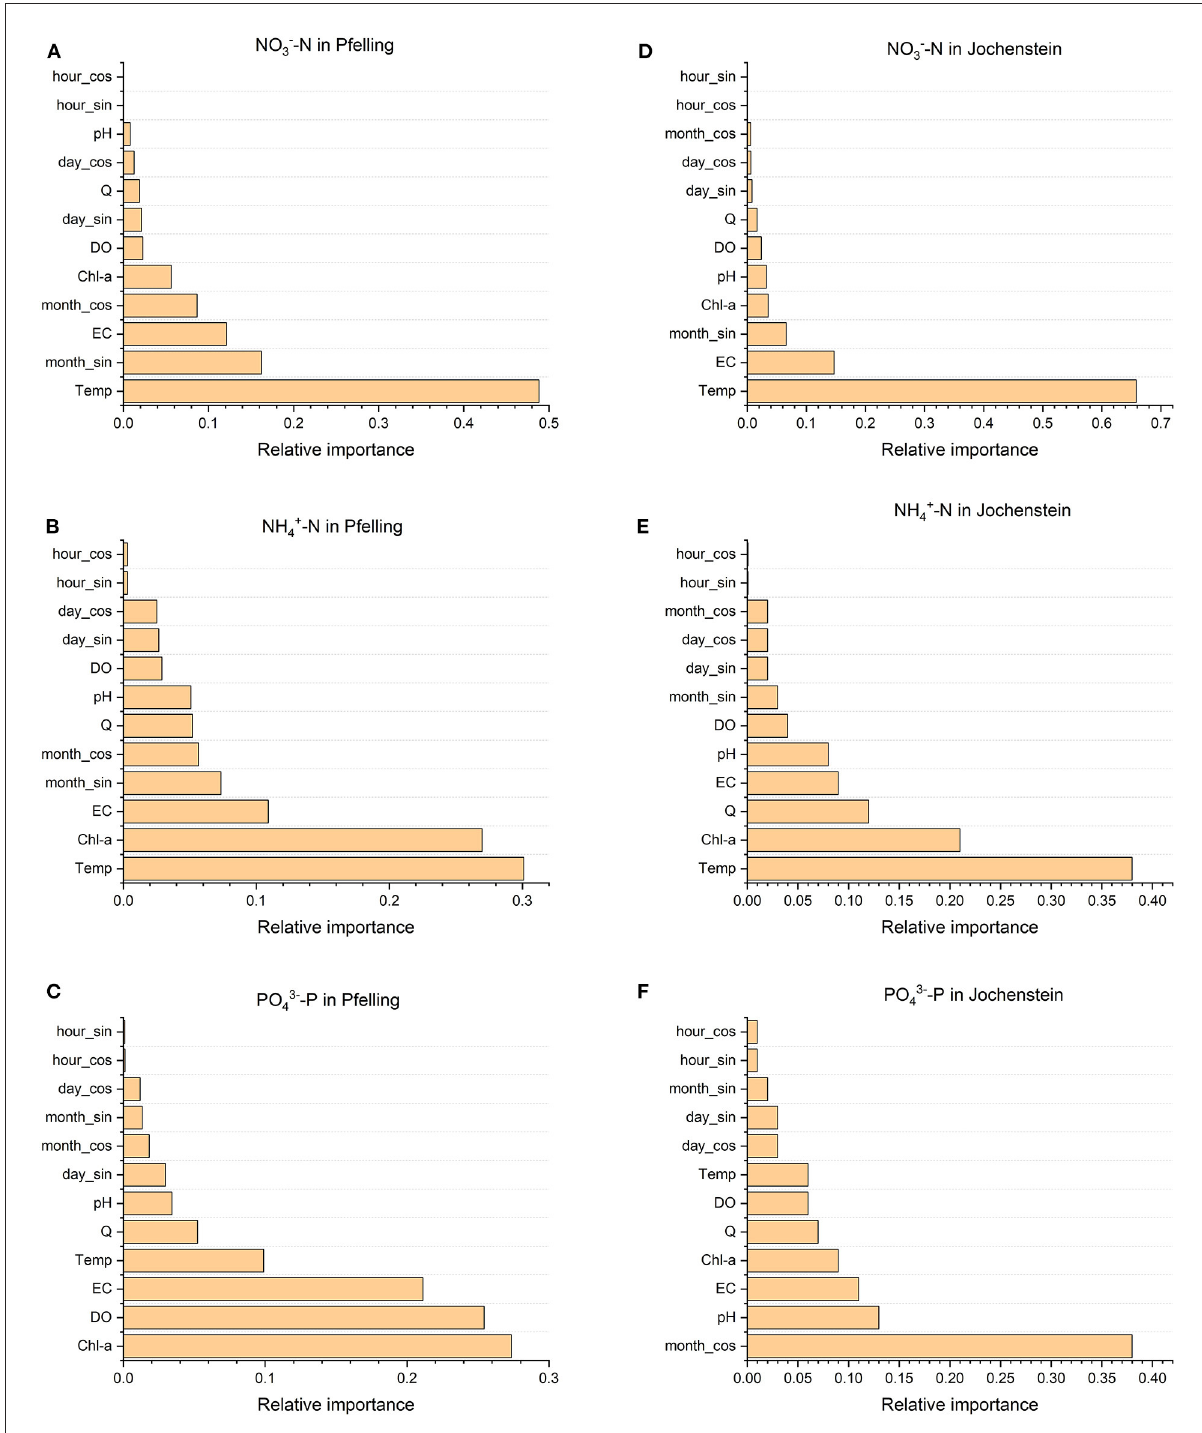
FIGURE4 Feature importances in RF models of different nutrients in Pfelling and Jochenstein station. (A) NO − 3 -N Pfelling. (B) NH + 4 -N Pfelling. (C) PO 3 − 4 -P Pfelling. (D) NO − 3 -N Jochenstein. (E) NH + 4 -N Jochenstein. (F) PO 3 − 4 -P